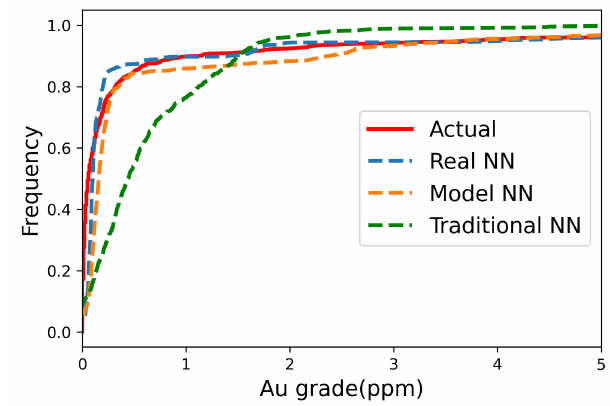
Figure 10. Simulation 23, cumulative distribution of actual and NN